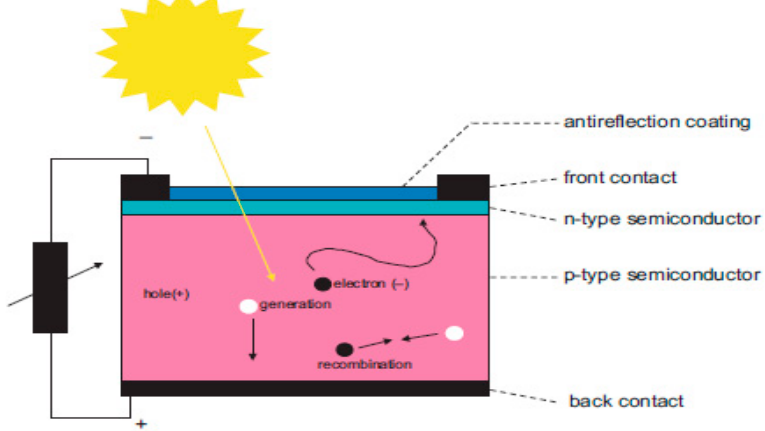
Figure 2. Schematic cross-section of a solar cell. Each cell can provide 2.4 A with an output voltage from 0.5 to 0.6 V according to its size. The basic unit in the PV system is the PV cell, whereas the combination of cells (series and parallel) forms modules; combining these modules results in PV panels, whilst some panels can create the PV